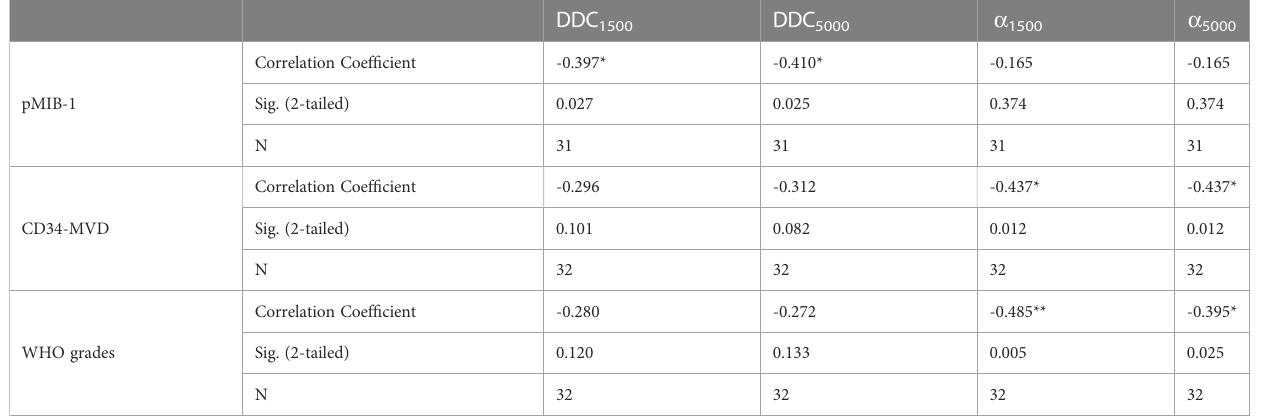
TABLE 2 Correlations of SEM-derived parameters with MIB-1, CD34, and WHO